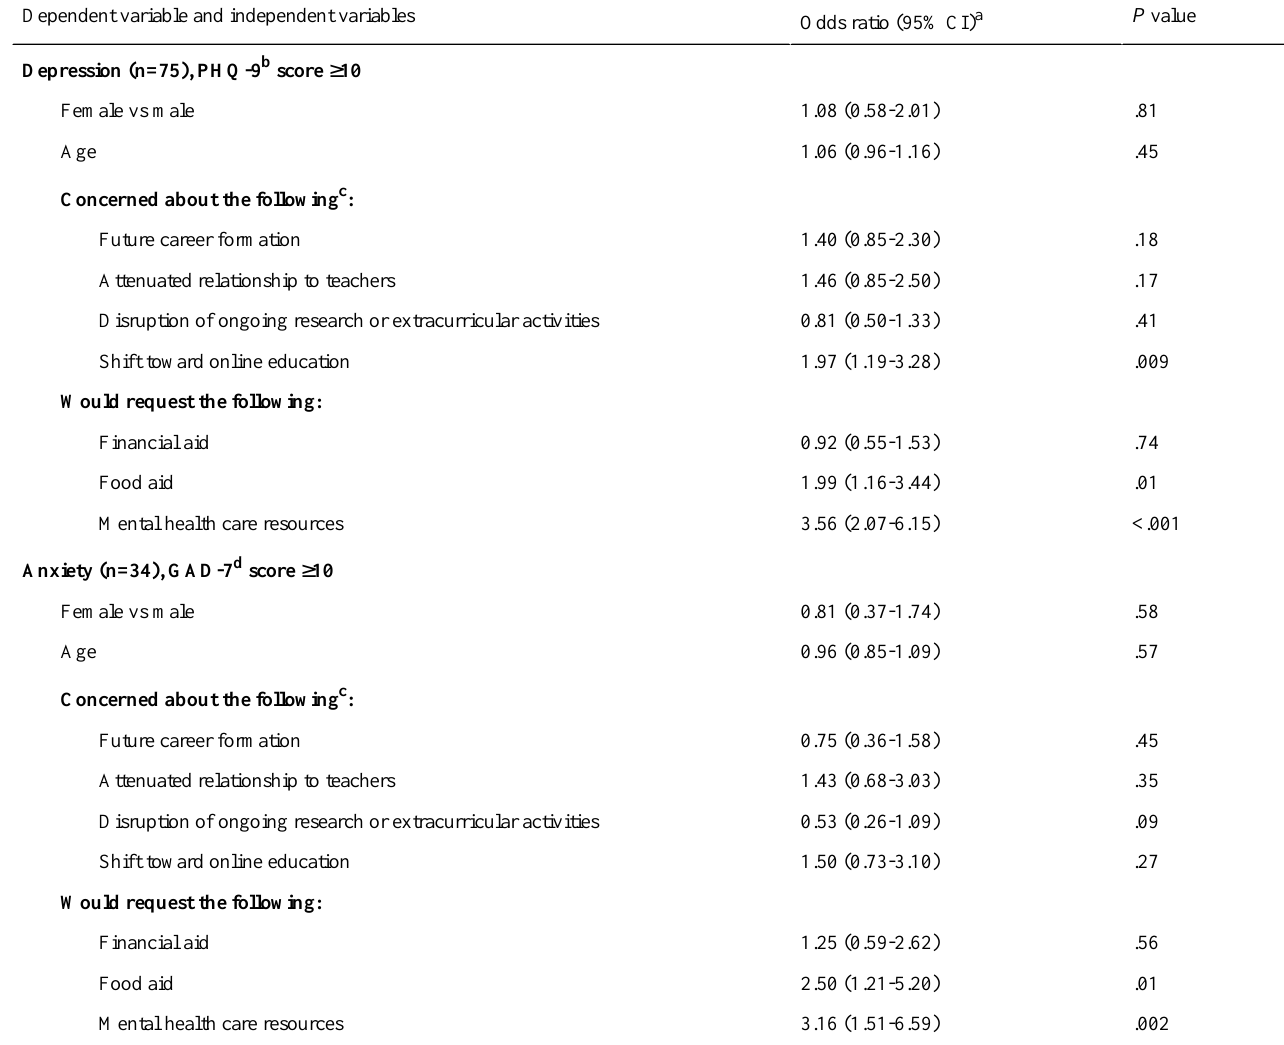
P valueOdds ratio (95% CI) a Dependent variable and independent variables